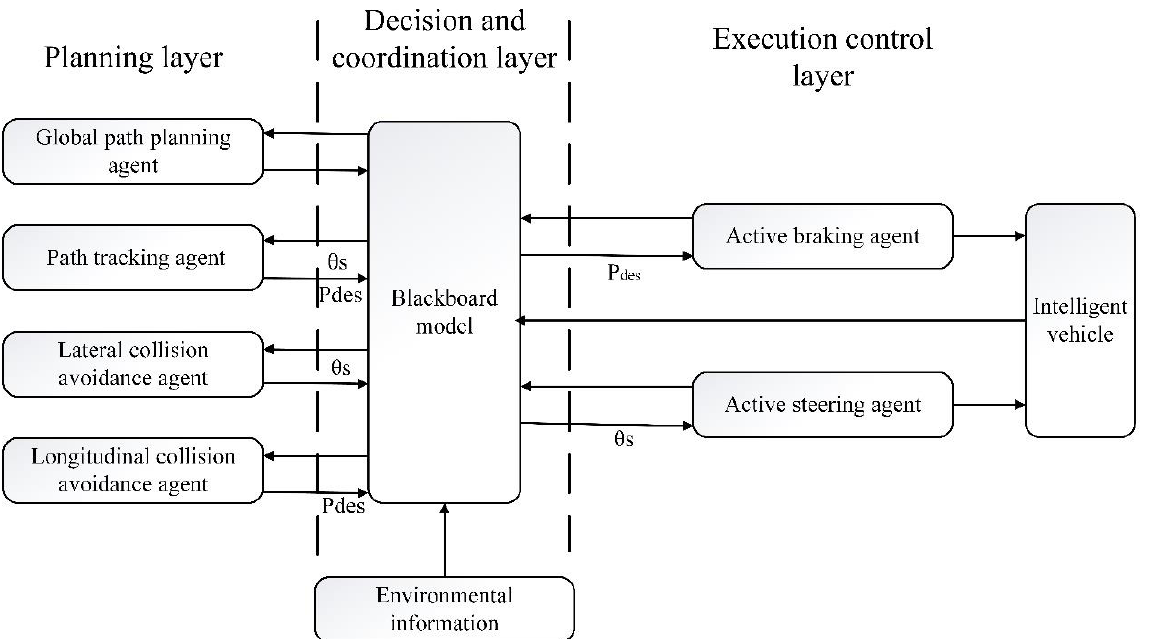
Figure 4. Multi-agent coordinated control system based on blackboard model. During the driving process, the information acquired by the environment perception layer is uploaded to the blackboard in real time, and each agent obtains information by interacting with the blackboard. When an obstacle appears on the default path, longitudinal and lateral collision avoidance agents are activated. The brake pressure and steering wheel angle are uploaded to the blackboard separately. If the two agents are activated at the same time, a choice must be made by the coordinated control module according to the actual